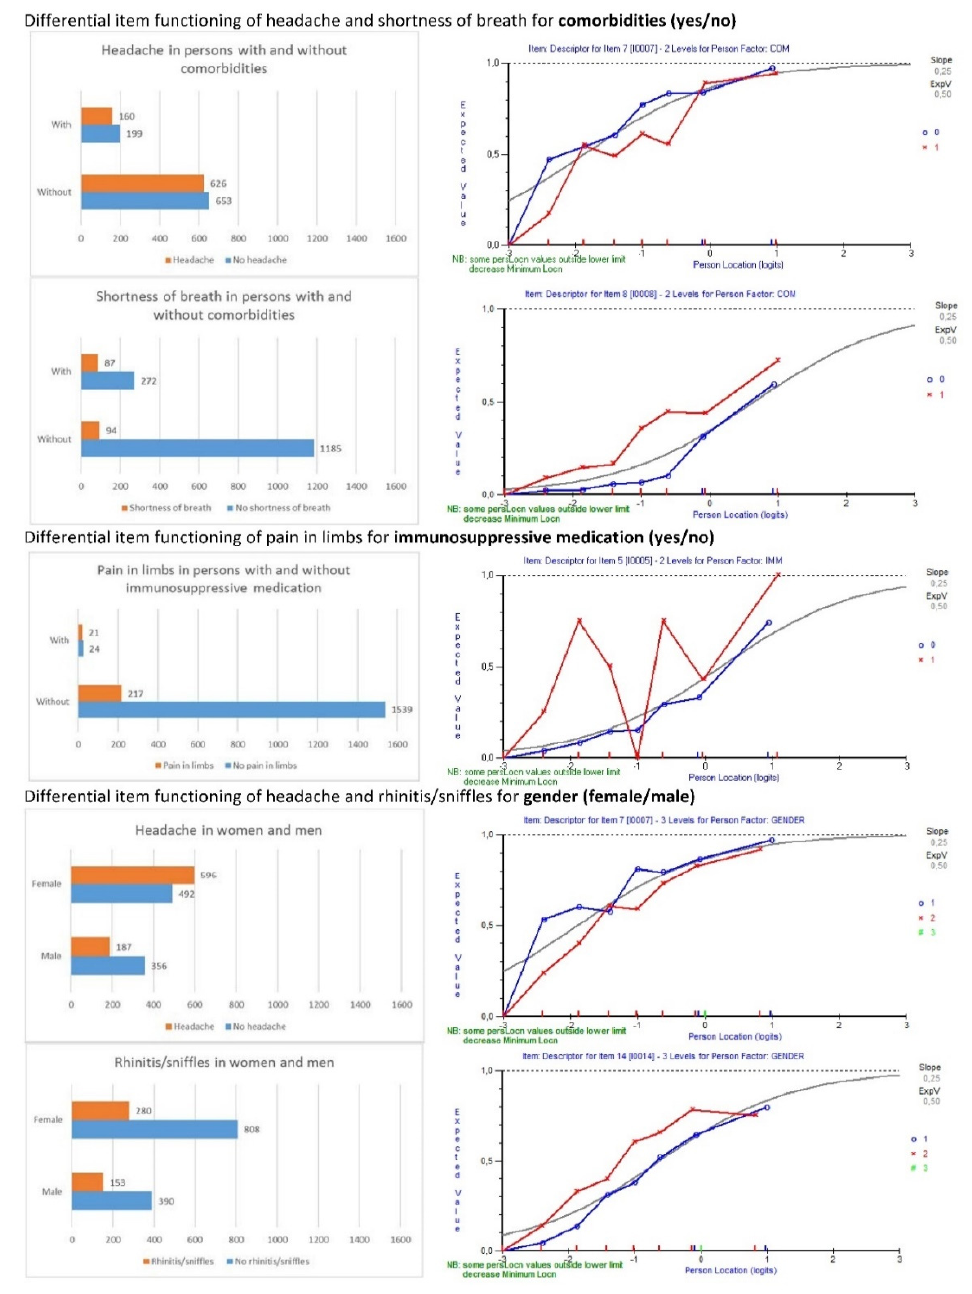
Figure 1. Differential item functioning for comorbidities, immunosuppressive medication and